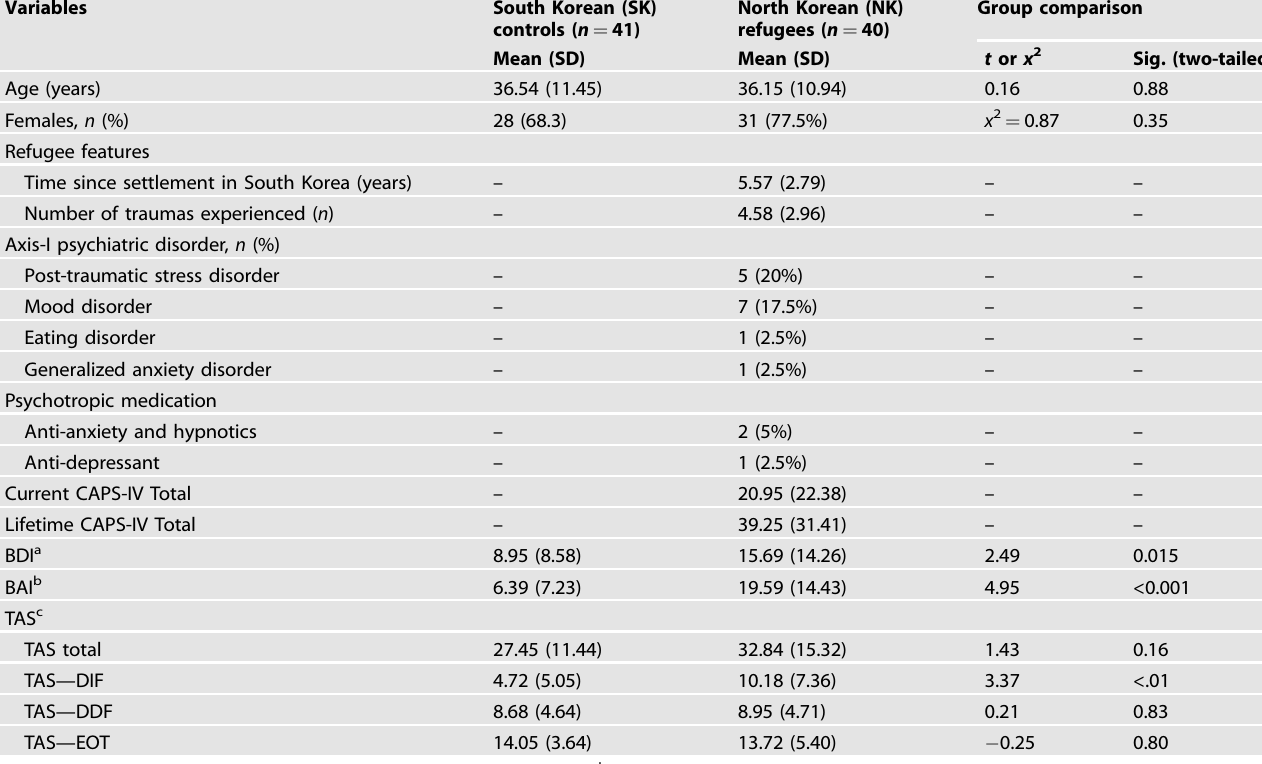
Table 1. Demographic and clinical characteristics of the study